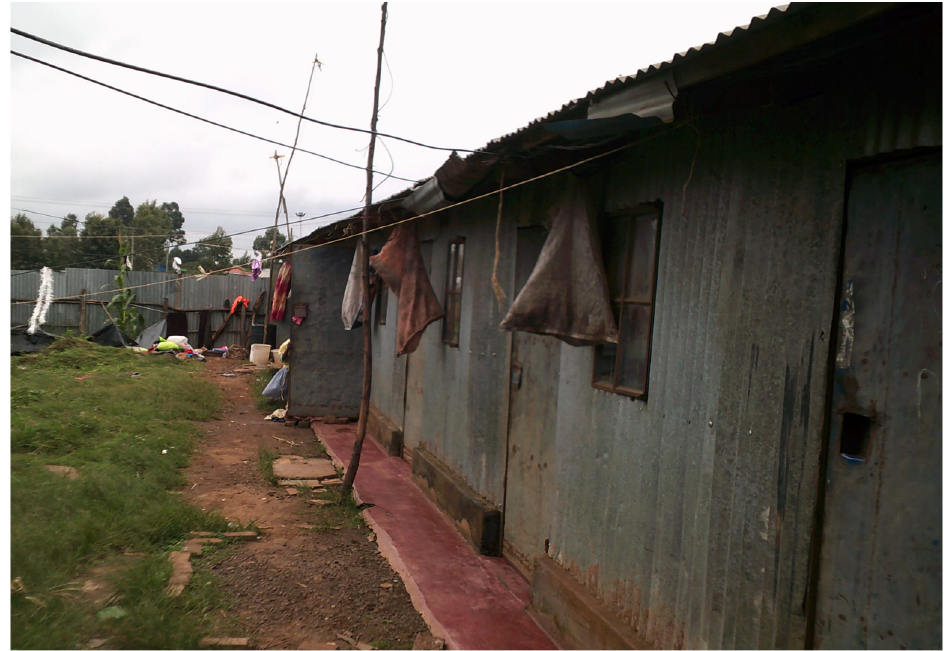
Figure 2. A ghettoized house showing the poor lifestyle of vulnerable LGBTI refugees living on the outskirts of Nairobi.